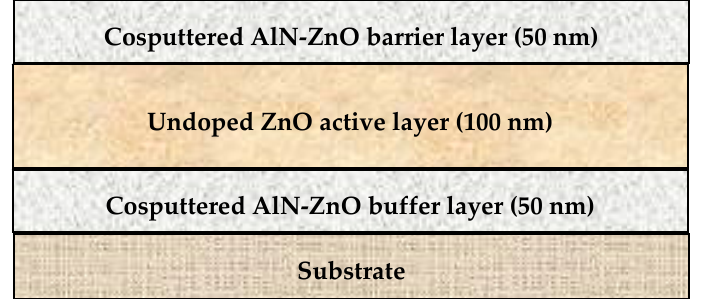
Figure 1. A schematic structure of the AlN-ZnO/ZnO/AlN-ZnO double heterojunction structure. Film thickness was measured using a surface profile system (Dektak 6M, Veeco, Plainview, NY, USA). The electrical properties of the undoped ZnO and cosputtered AlN-ZnO films as